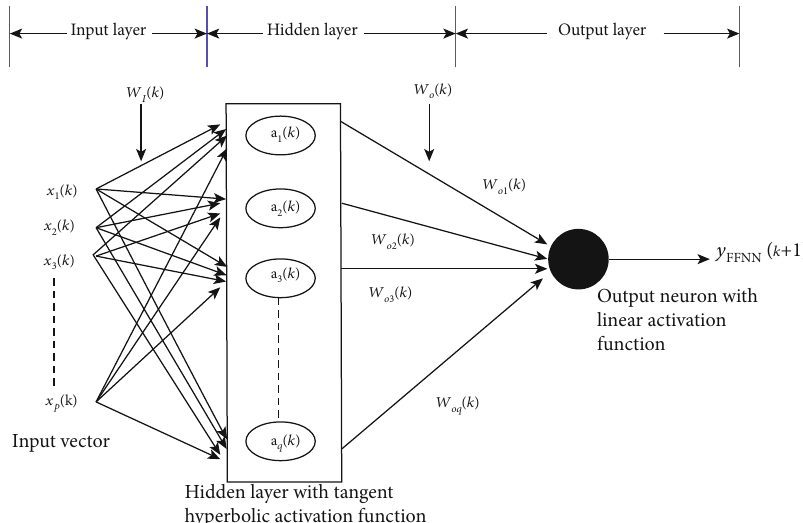
Figure 1: A feedforward neural network structure.